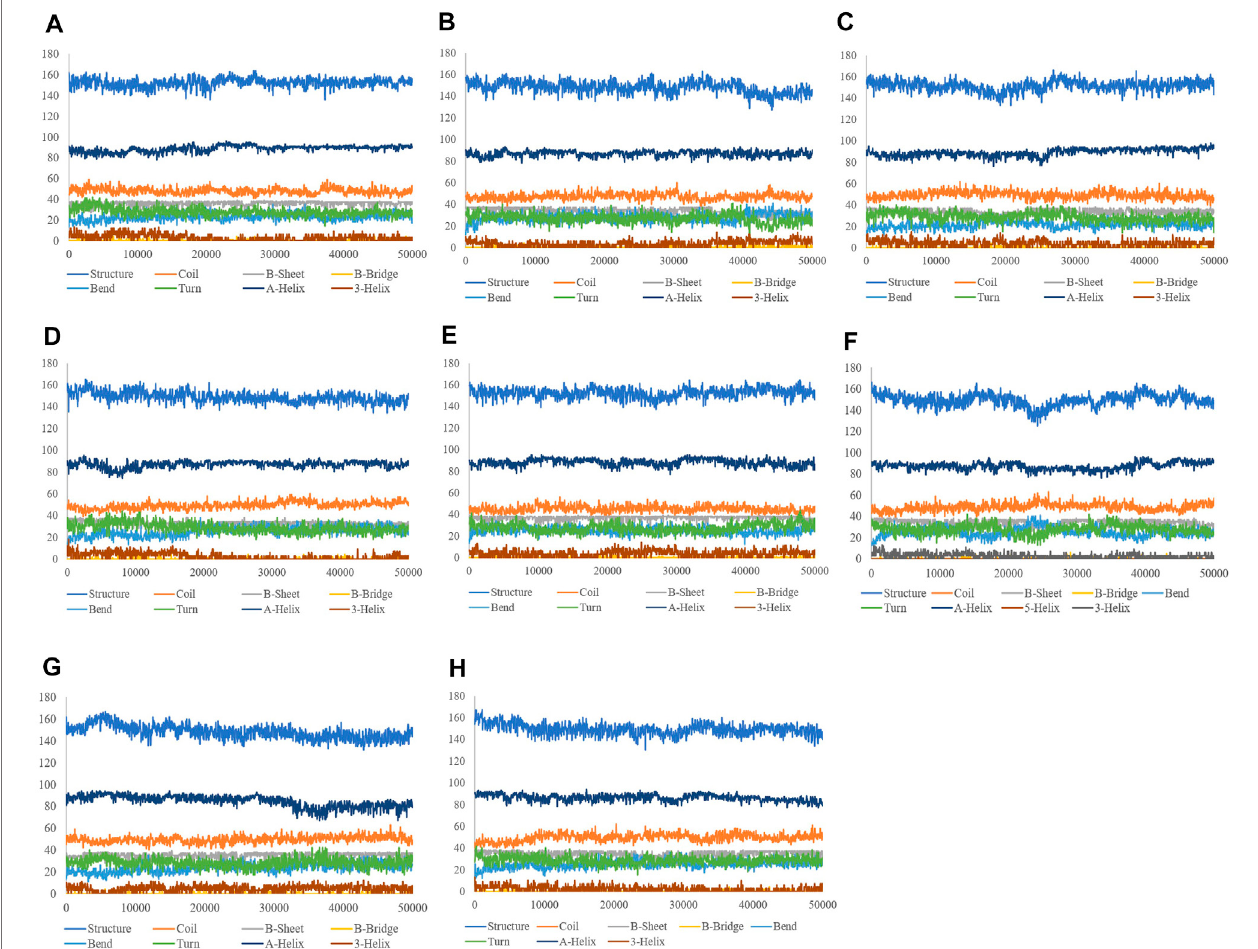
Figure 6 and Supplementary Figure S2 . The 3D structures have also been displayed in Figure 7